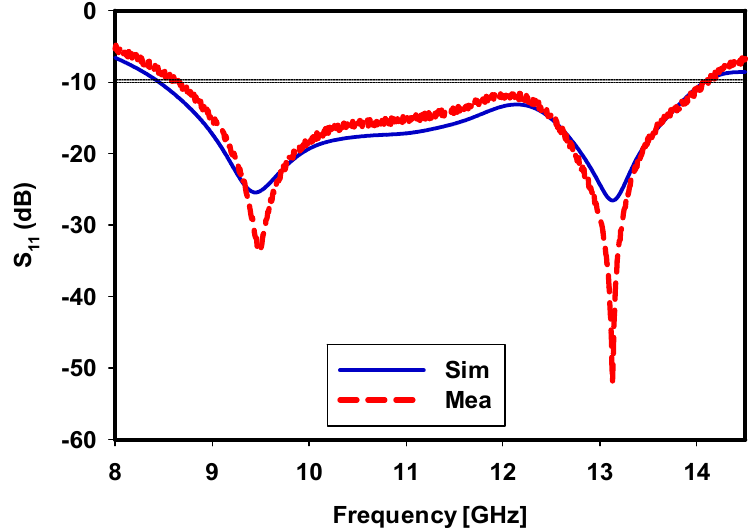
Figure 10. Simulated and measured reflection coefficients of the proposed design.